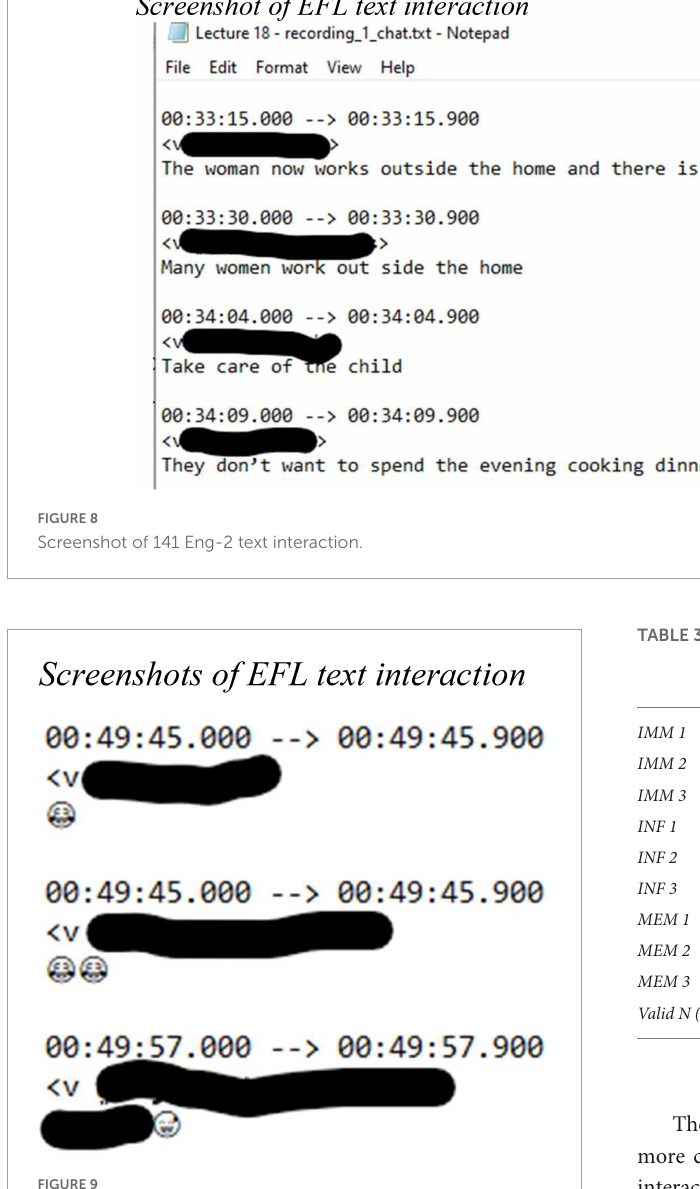
FIGURE9 Screenshot of using emoticons in text interaction.